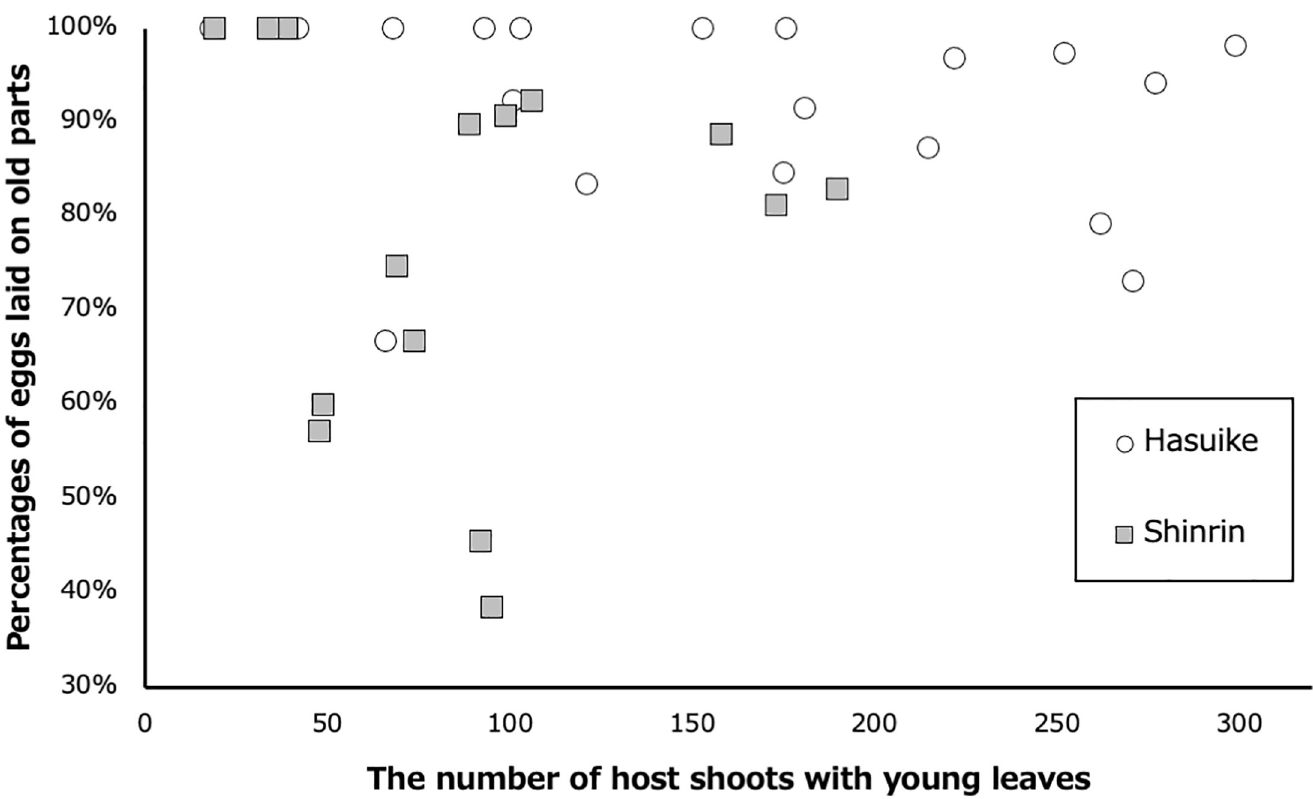
Fig 2. Relationship between the number of L . edulis shoots with young leaves and percentages of A . bazalus eggs laid on old host foliage in Shinrin Park and Hasuike Park, Saga, Kyushu, Japan in 2015.